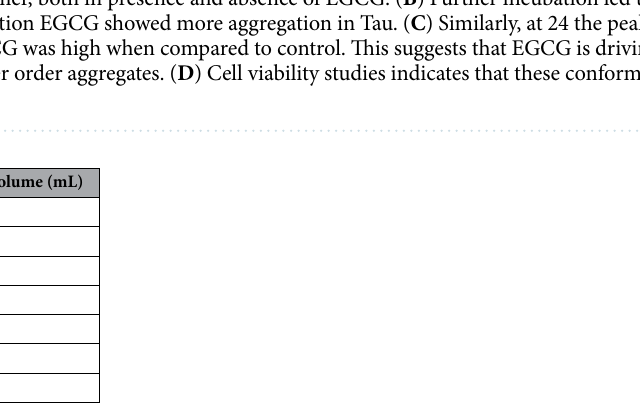
Table 2. Peak retention volumes for EGCG treated and untreated